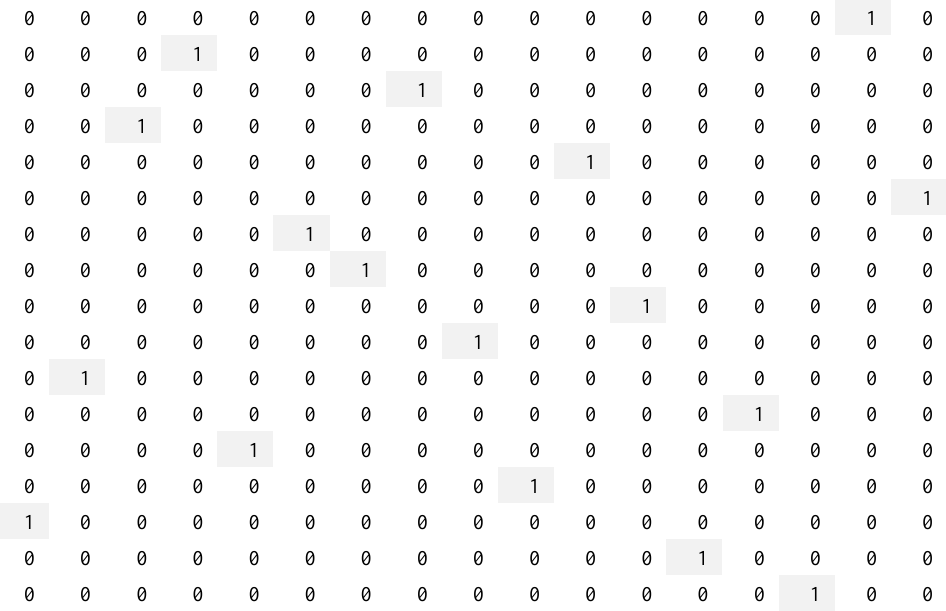
Table 5. Optimum facility